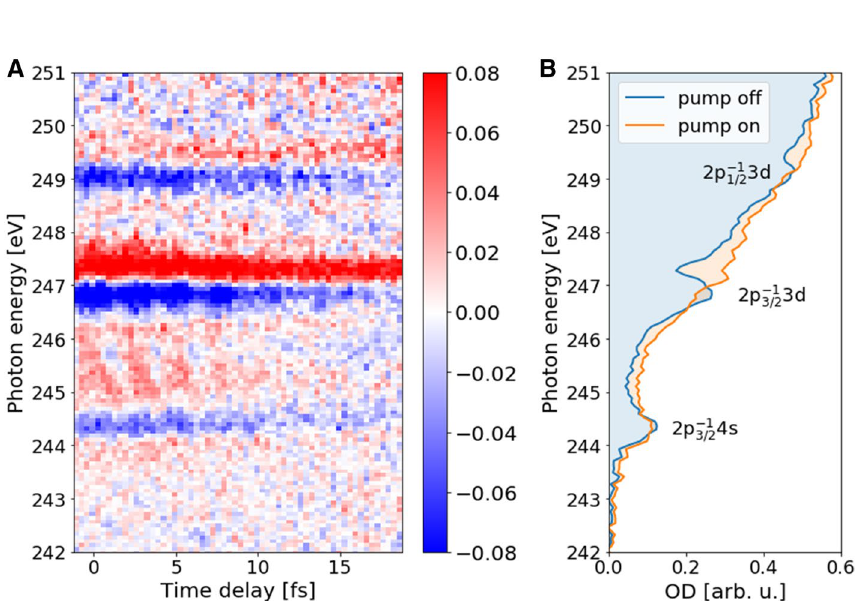
Figure 6. SXR absorption spectra of argon. SXR absorption spectra in the vicinity of L 2,3 -edge of argon as a function of pump-probe delay ( A ). SXR-probe pulse precedes mid-IR-pump pulse. SXR absorption spectra without and with mid-IR pump ( B